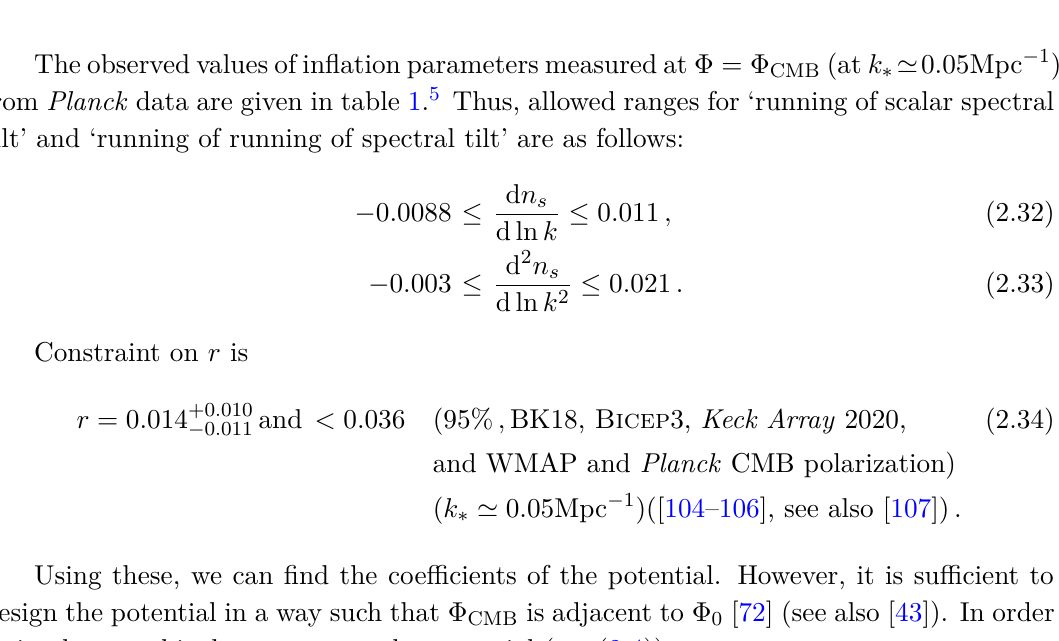
Table 1. Planck data of